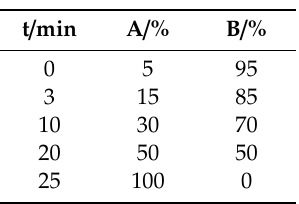
Table 7. Gradient HPLC elution